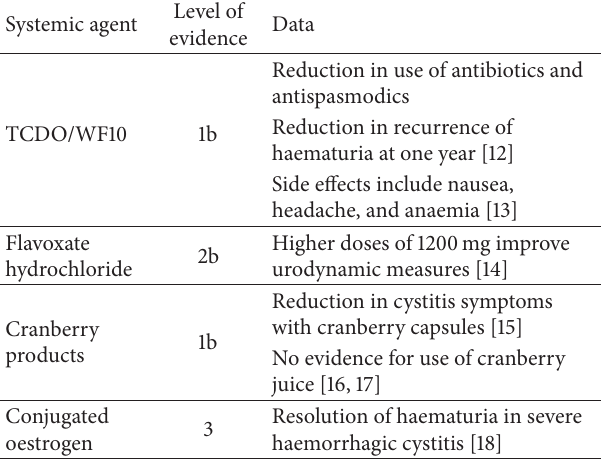
Table 3: The proposed systemic treatments for radiation cystitis and their levels of